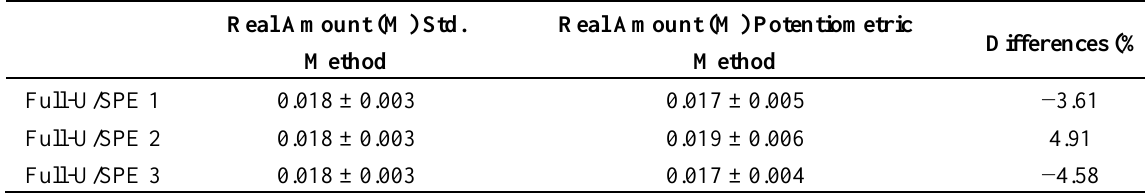
Table 4. Comparison of the responses of fabricated electrode by potentiometric method and UV-Vis standard